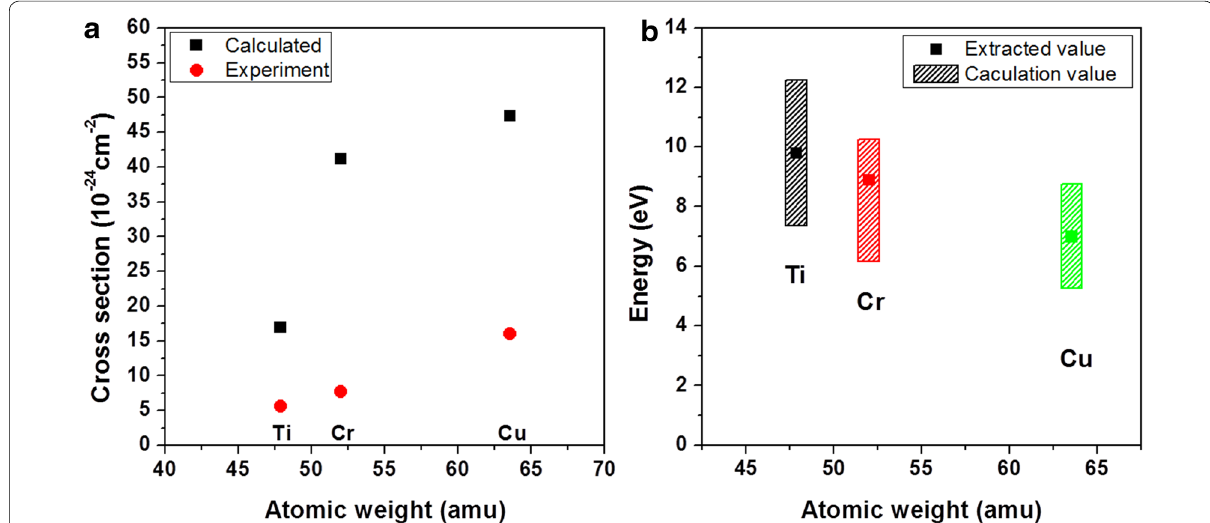
Fig. 4 Calculated vs. experimental values of a displacement cross‑section and b displacement